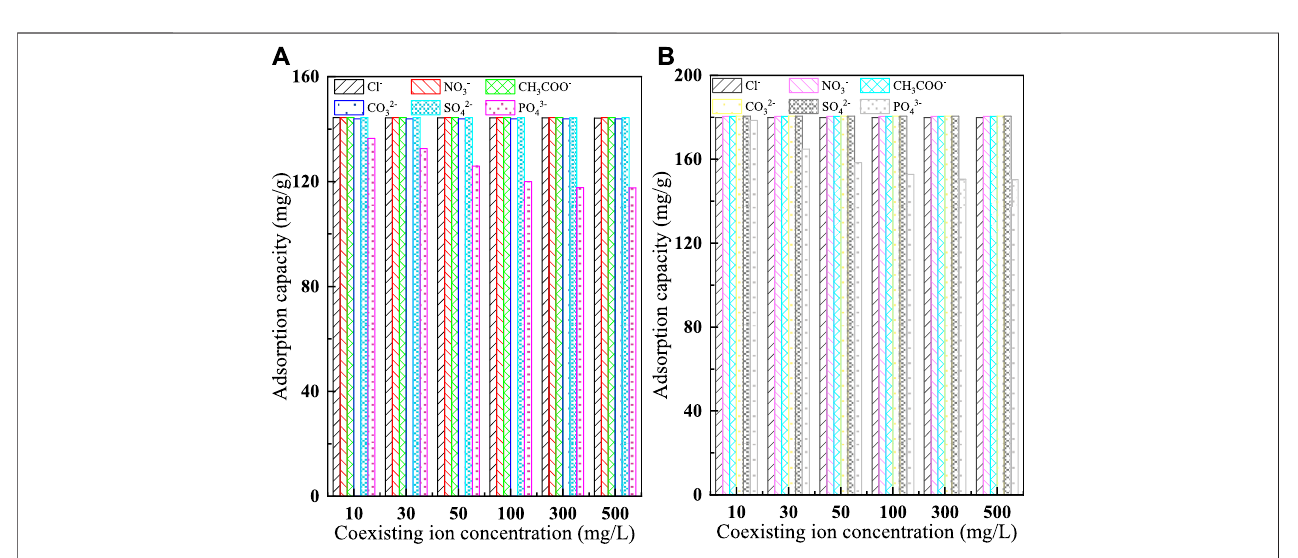
FIGURE 9 | Effect of coexisting anions on the adsorption of fl uoride about C-SAA and C-SAAoa.